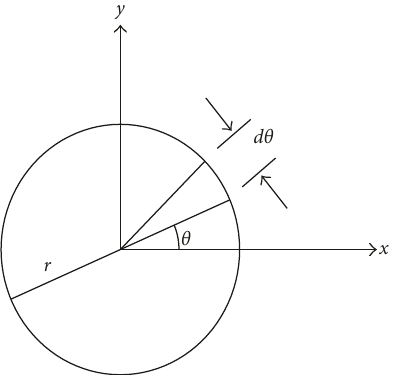
Figure 10: Orientation model of short fibres randomly distributed in a plane.